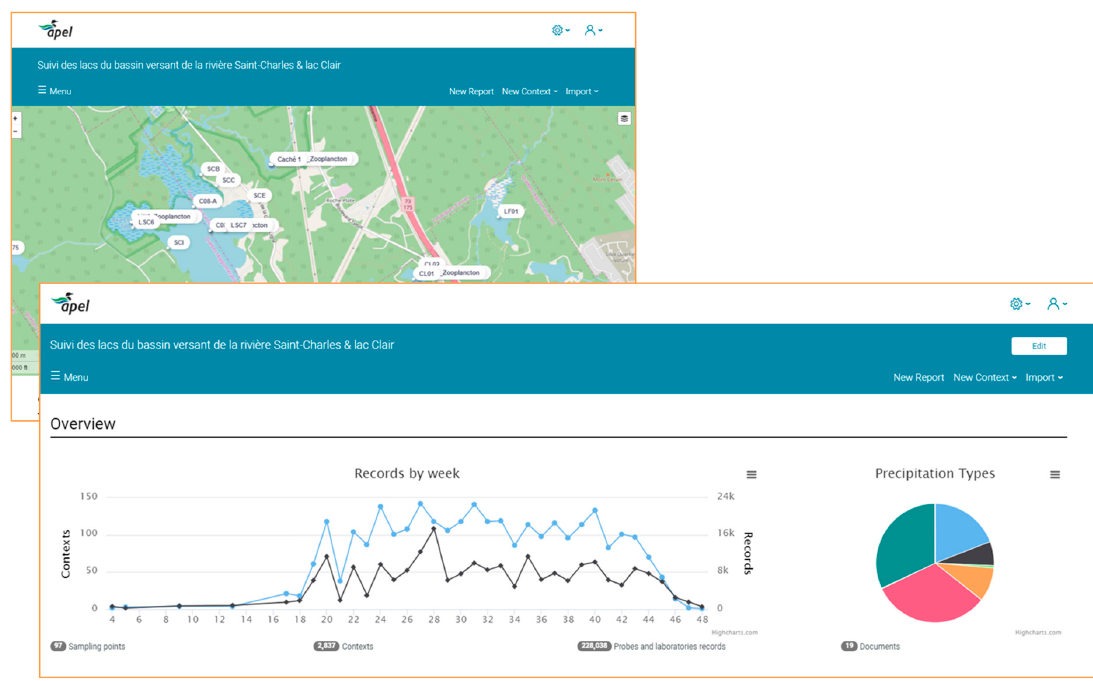
Figure 5. Illustration of the dashboard of the W1 WQMP, as well as the features that may be consulted to understand the WQMP and the available data